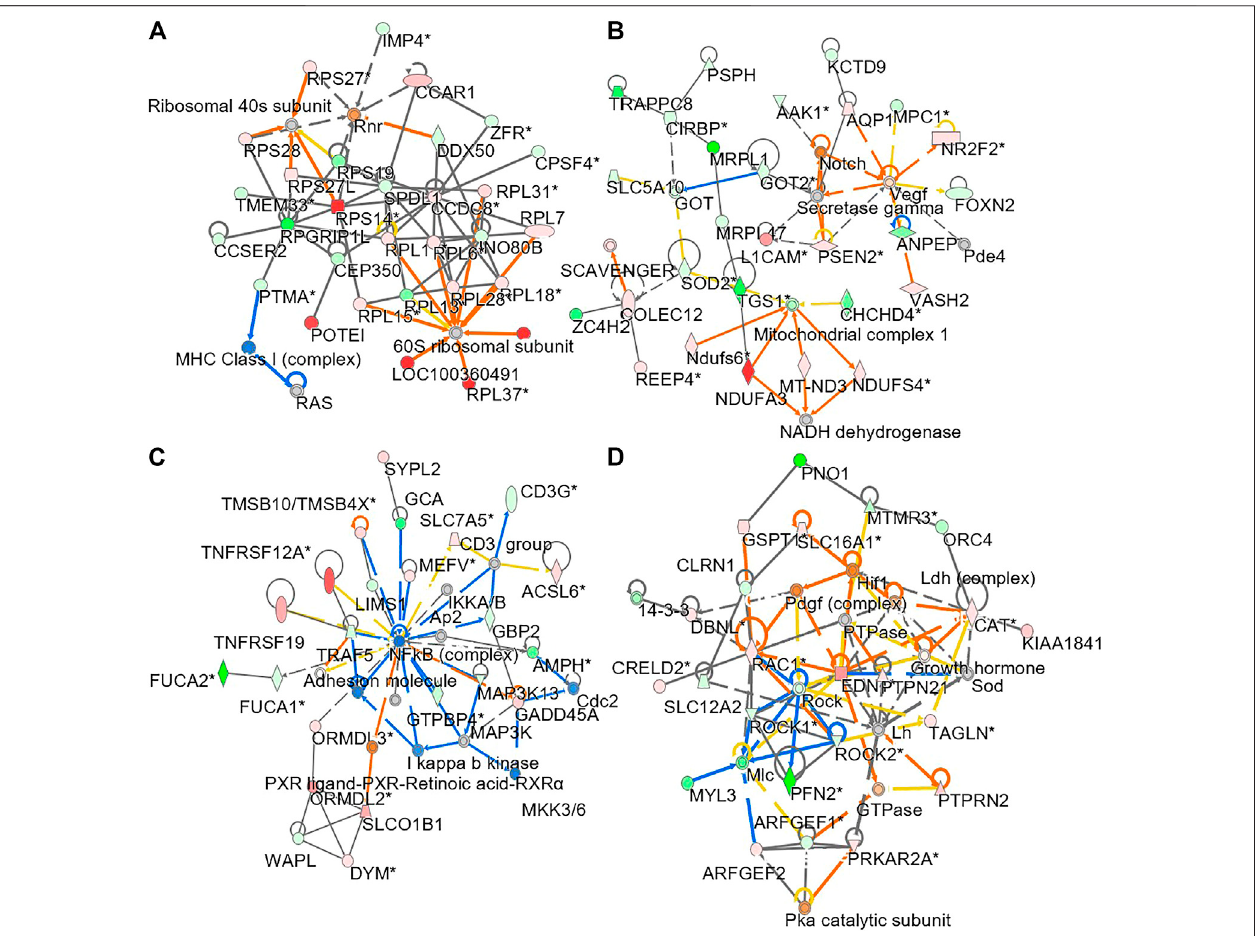
FIGURE 7 | Network analysis of integrated omics data. The treatment of osteoblasts was as that in Figure 1 . From the results of transcriptomics, proteomics and lipidomics,theregulatedparameterinrespondingtothetreatmentsofDBTandDBT Δ cal wasconductedbymolecularnetworkanalysis.Thenetwork (A – D) wasobtained by analyzing the DEGs, DEPs, and DEMS using Ingenuity